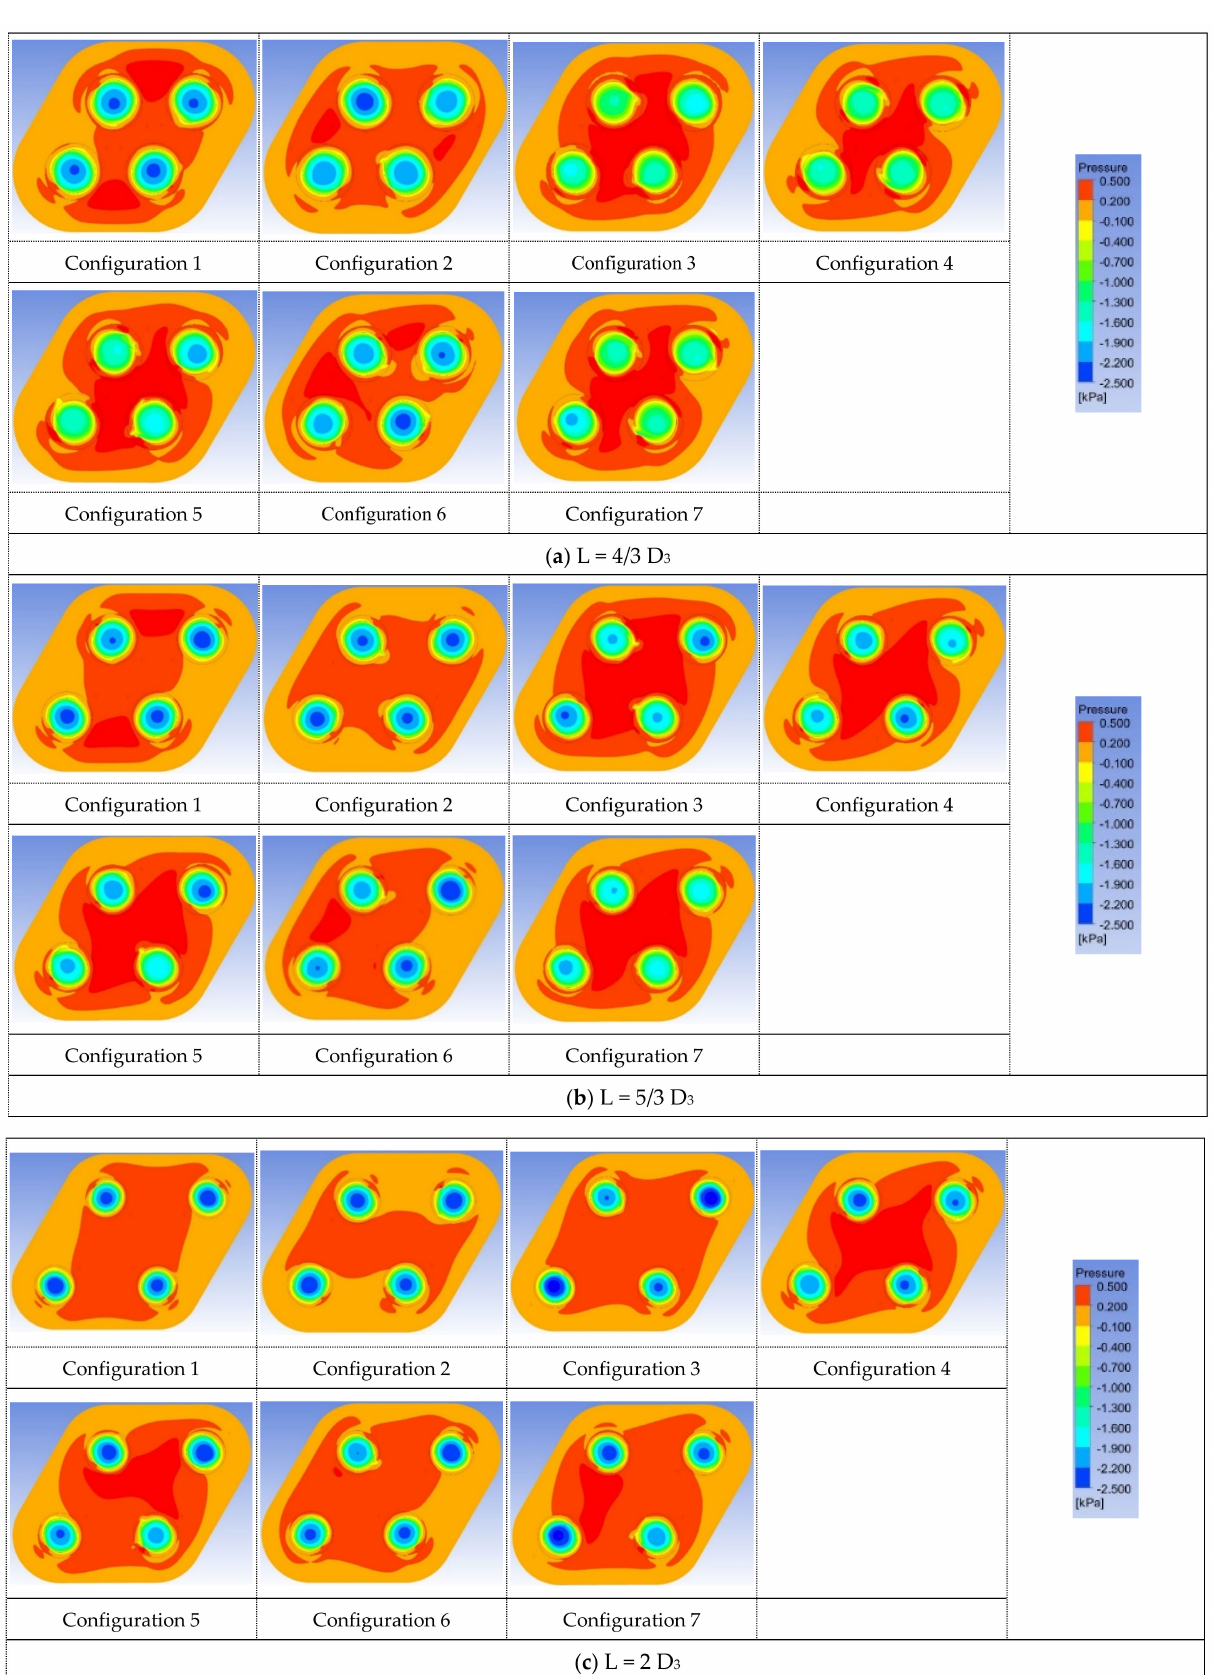
Figure 13. Pressure distribution of quad-vortex grippers. ( a ) L = 4/3 D 3 , ( b ) L = 5/3 D 3 , ( c ) L = 2 D 3